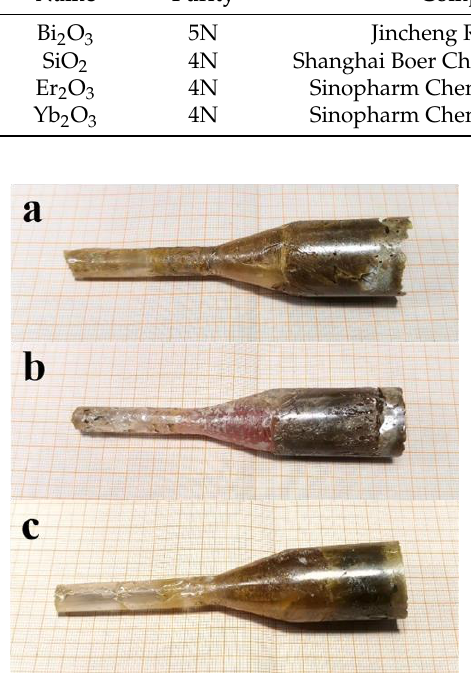
Figure 1. As-grown ( a ) pure BSO, ( b ) Er: BSO, and ( c ) Er/Yb: BSO crystals.